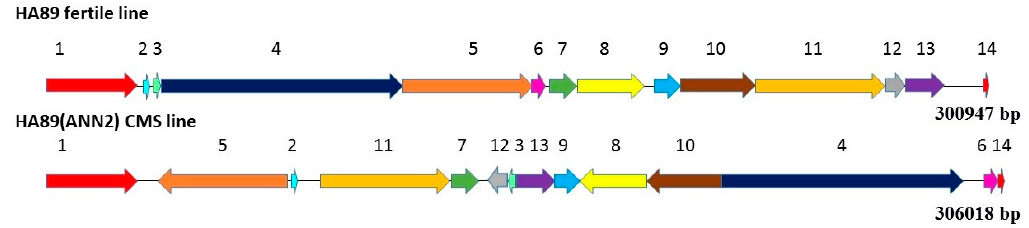
Figure 2. Schematic illustration of homologous regions between mitochondrial genomes of HA89 male-fertile and HA89(ANN2) CMS lines. 1—29,196 bp; 2—557 bp; 3—1245 bp; 4—77,441 bp; 5—41,702 bp; 6—4150 bp; 7—8584 bp; 8—21,433 bp 9—8158 bp; 10—24,687 bp; 11—41,505 bp; 12—6029